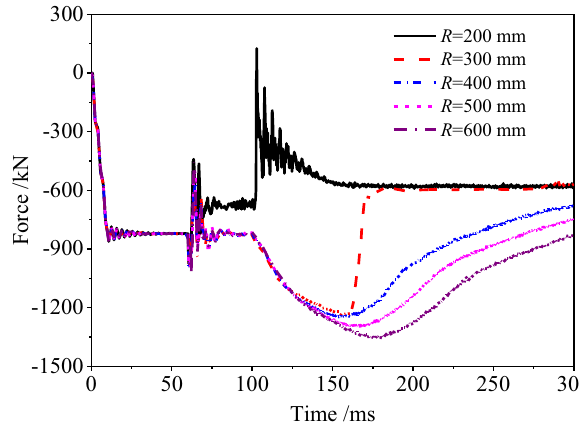
Fig. 14 Comparisons of the load–displacement responses for the RC bridge pier.